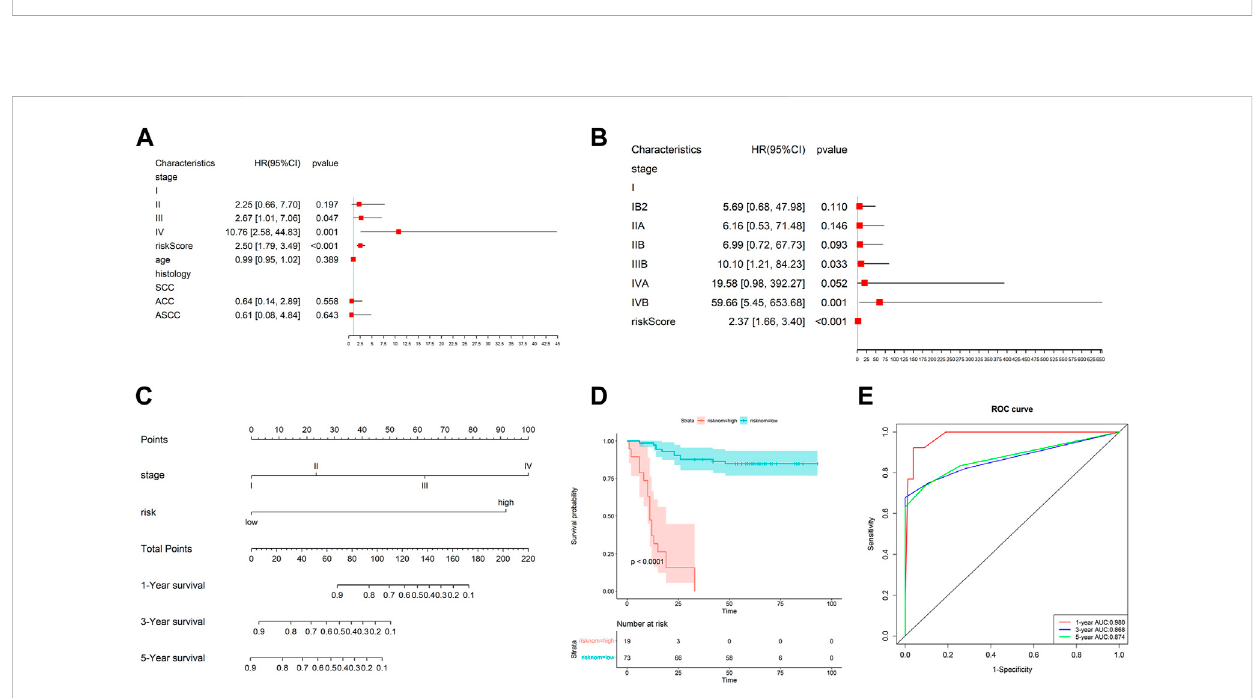
FIGURE 4 Effect of prognostic models and clinicopathological factors on survival. (A) Univariate Cox analysis of risk scores and other clinical features. (B) Multivariate Cox analysis showed the risk score was an independent prognostic factor. (C) Nomogram constructed by the risk score and clinical factors. (D) K – M analysis of the nomogram. (E) ROC curves of the nomogram on 1-, 3-, and 5-year